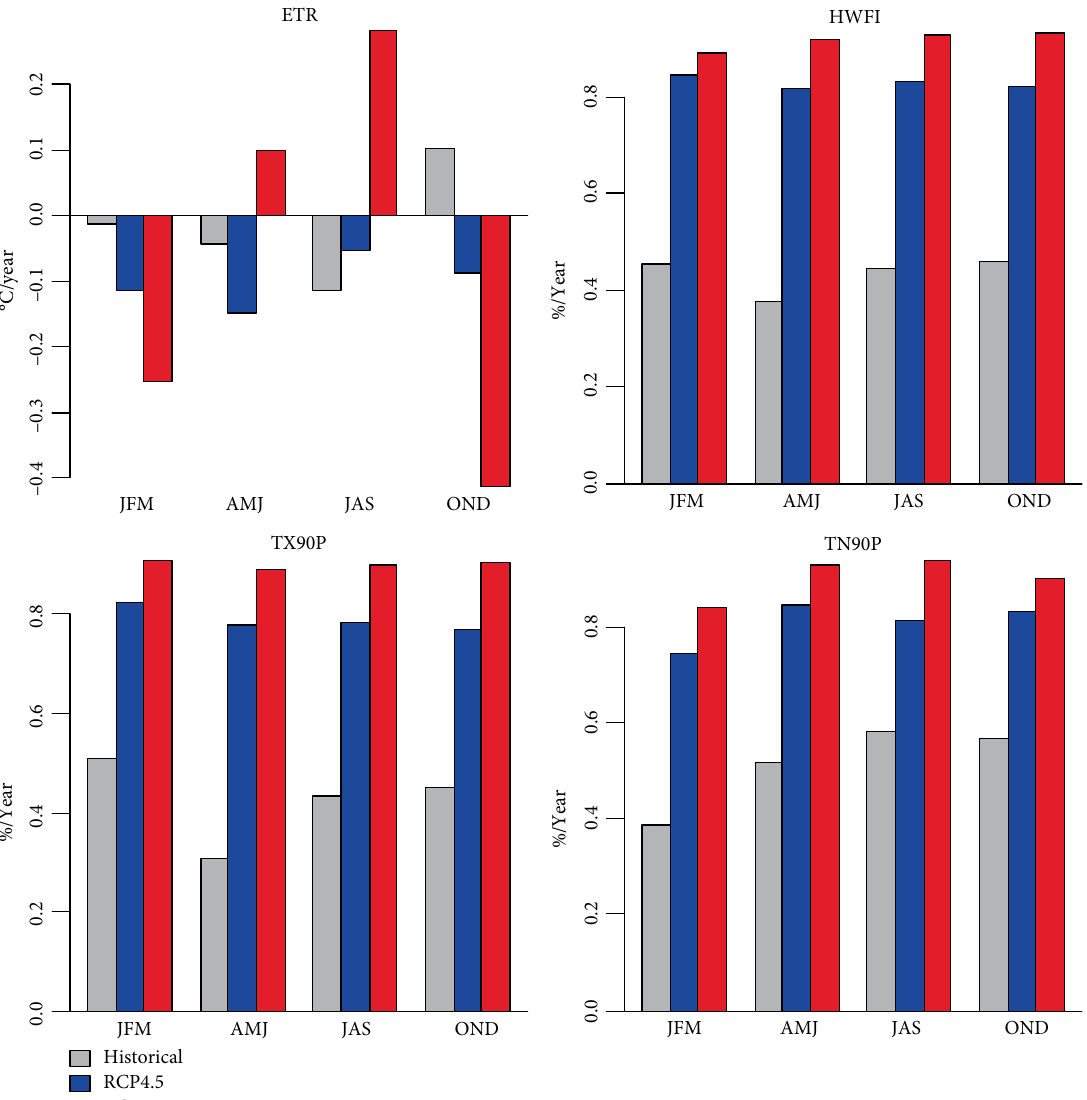
Figure 8: Comparison of the seasonal (JFM, AMJ, JAS, OND) trends of extreme temperature indices (ETR, HWFI, TX90P, TN90P) in Côte d’Ivoire for the historical (1976–2005) and future (2006–2100) periods under RCP4.5 and RCP8.5